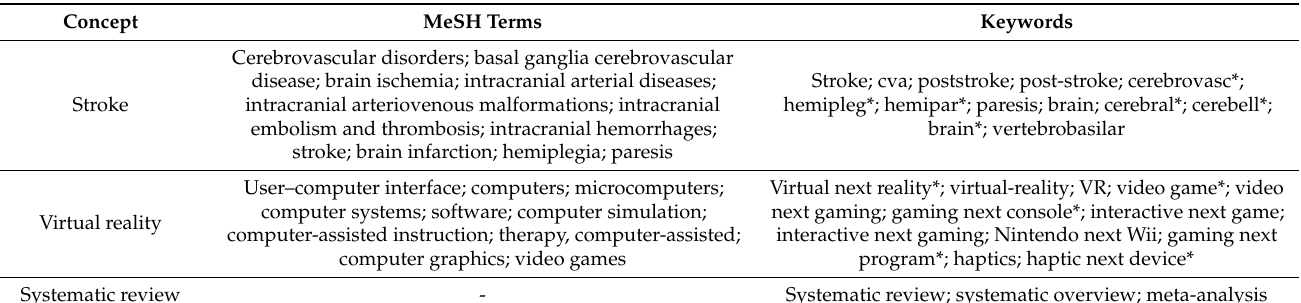
Table 1. Mapped medical subject headings (MeSH) terms and keywords employed in electronic search